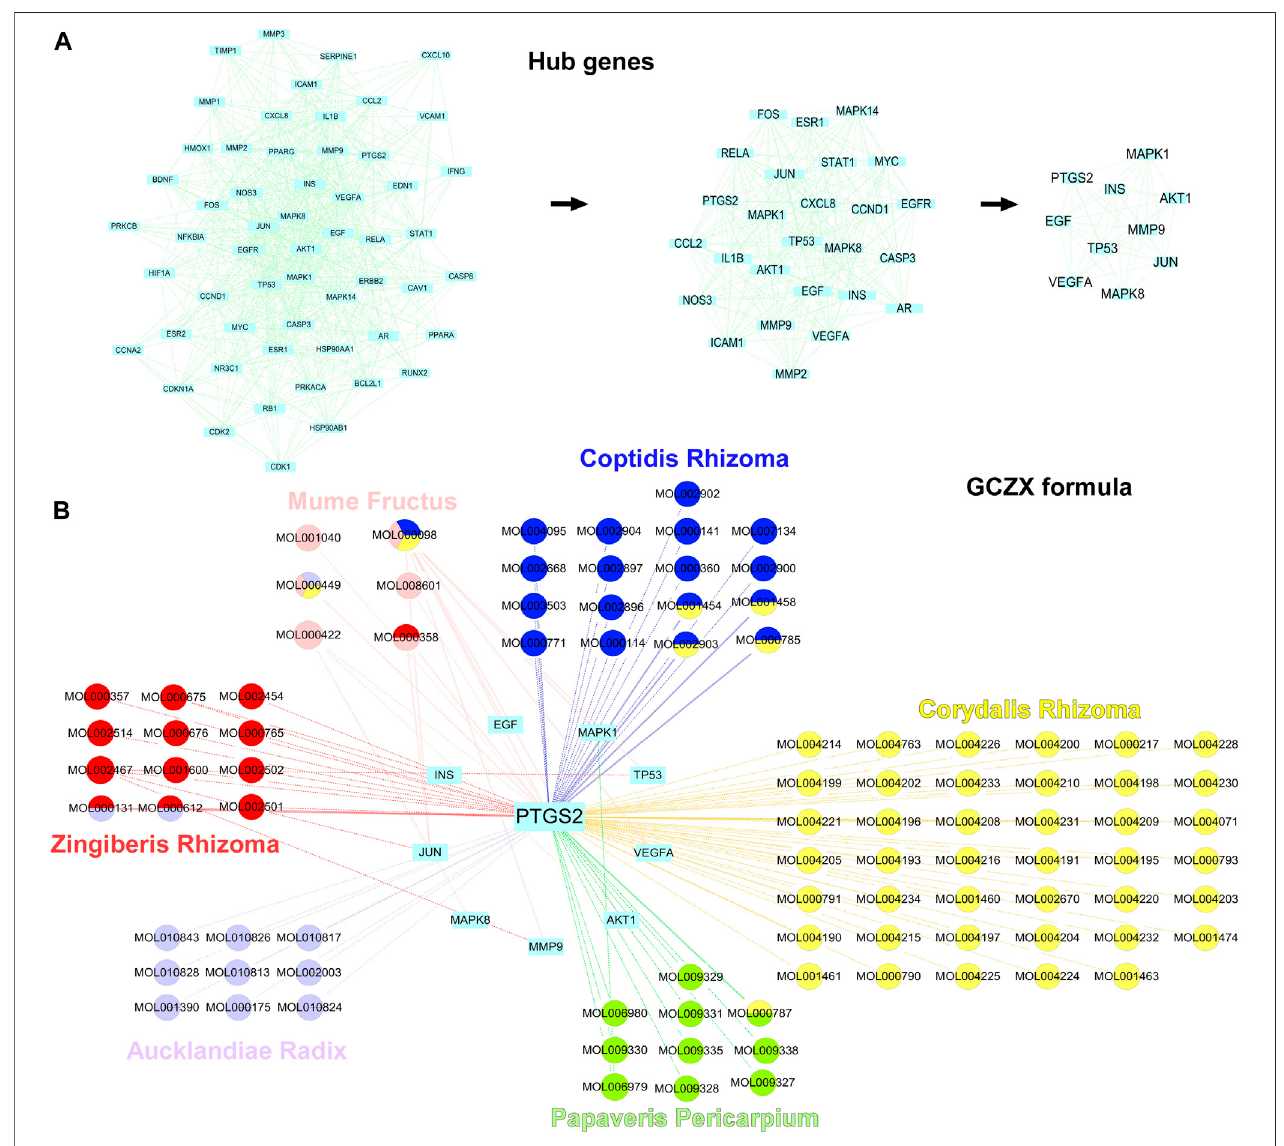
FIGURE 5 | Hub-genes of PPI network. Hub genes of PPI interaction network (A) ; Herbs and compounds as well as all hub-genes targets were linked (B) .